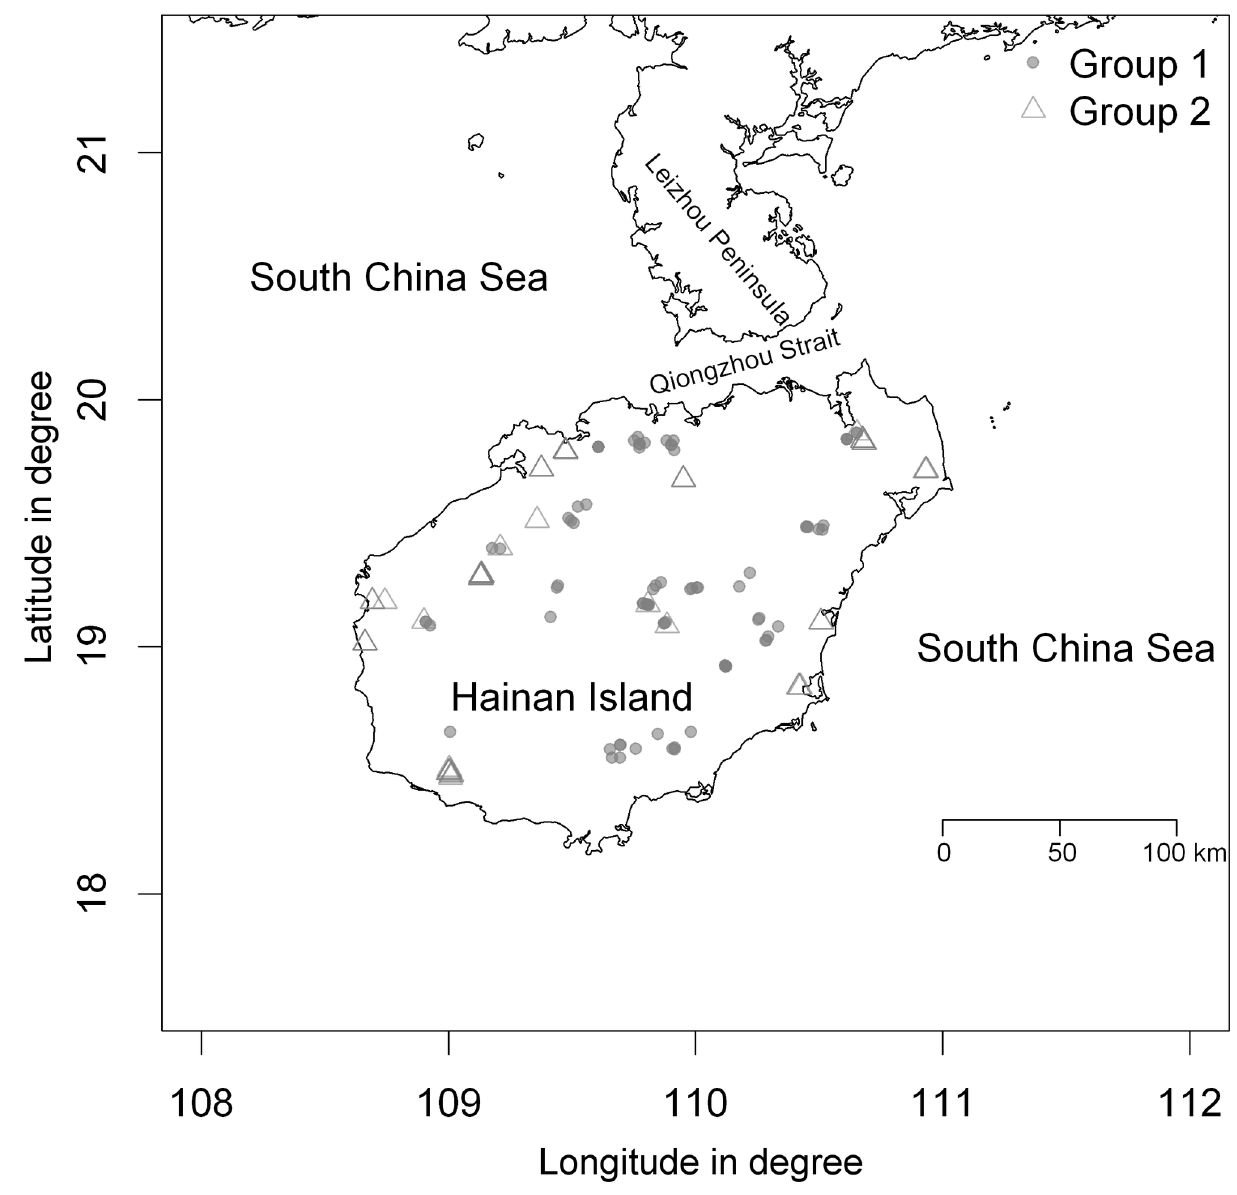
Figure 6. Clustering with the soil moisture constraint using MRT. Group 1 represents the sites with soil moisture greater than 11.55%. Group 2 represents those sites with soil moisture less than